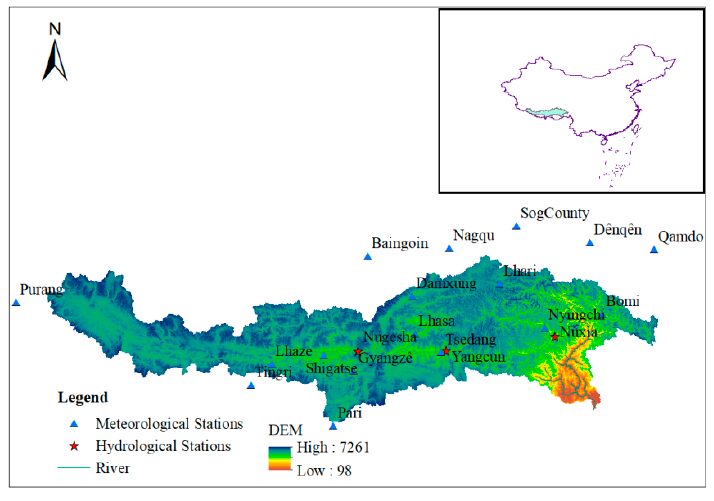
Figure 1. Location of the Yarlung Zangbo River (YLZR) basin and hydro-meteorological stations.